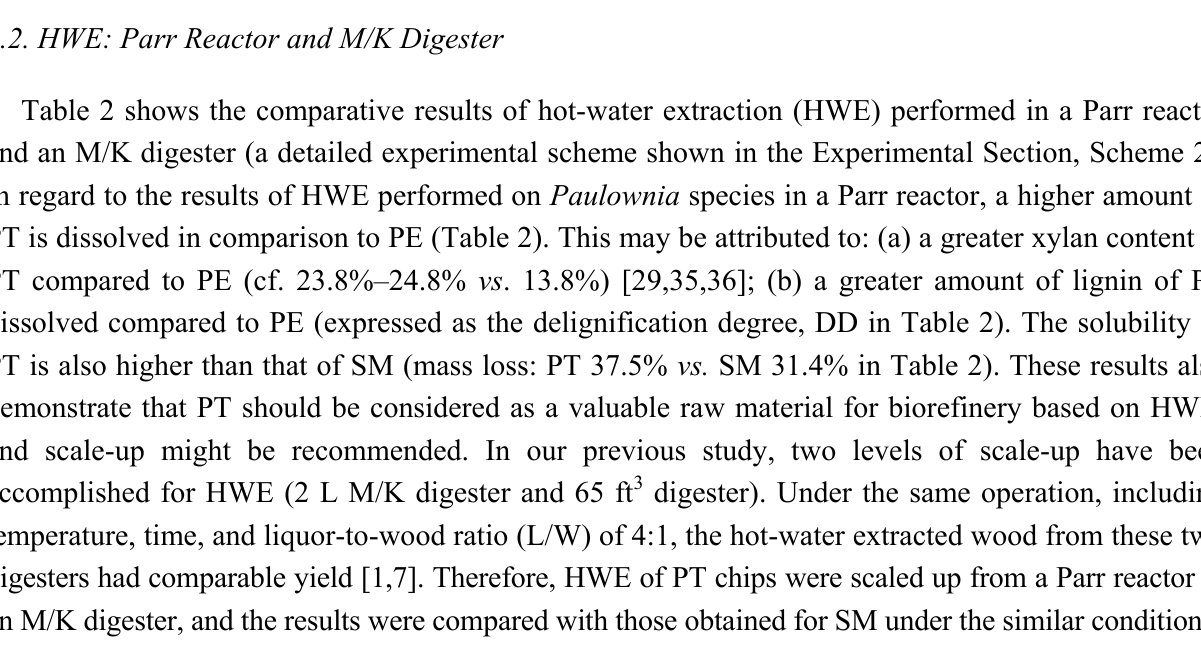
Table 2. The HWE comparison between Parr reactor and M/K